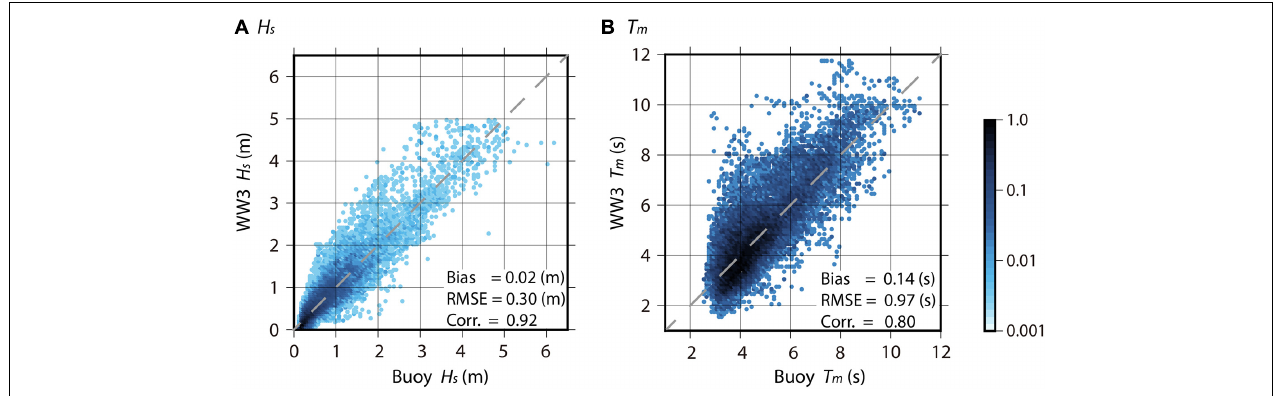
FIGURE 3 | Scatter diagrams of (A) H s and (B) T m between the ST6 model simulation ( Y –axis) versus buoy observation ( X –axis) for the open water condition. Statistical values are shown in the lower left corner of both panels. In this comparison, we used values only when the ice concentration in the coastal area